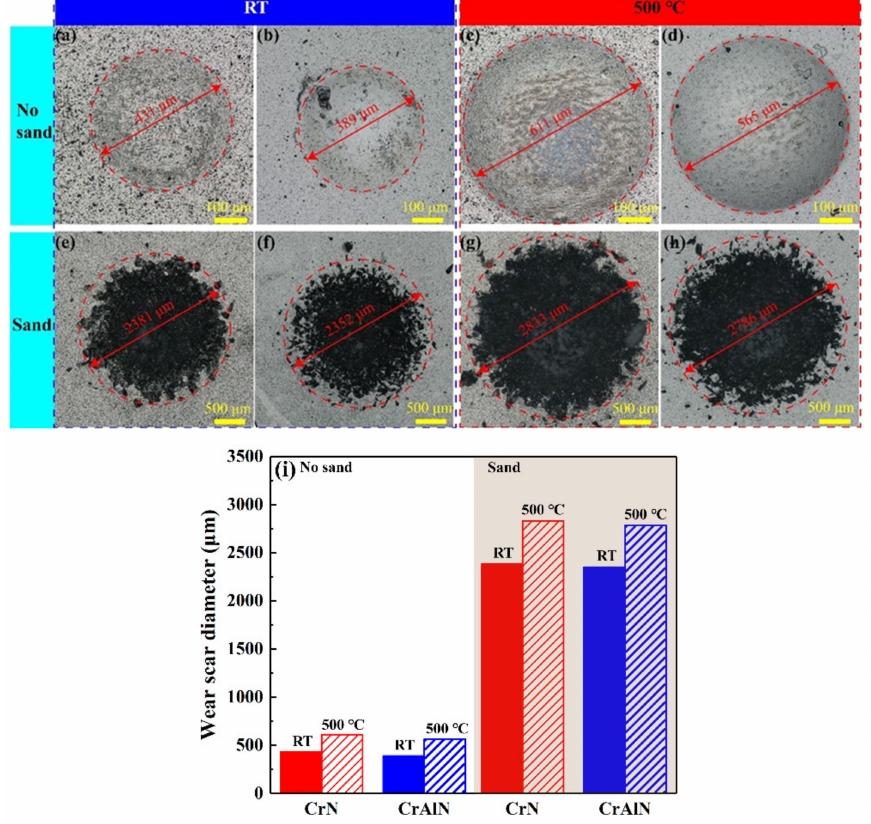
Figure 7. Optical microscope morphology and impact wear scar diameter: ( a , c , e , g ) CrN coating; ( b , d , f , h ) CrAlN coating; and ( i ) the wear scar